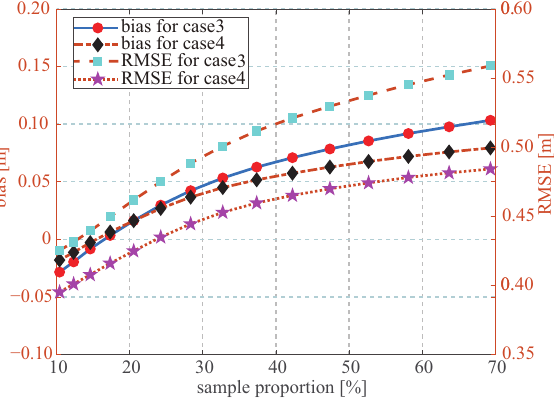
Figure 15. Biases and RMSEs of ANN-based SWHs versus sample percentage. Table 3. Confusion coefficients for neural network